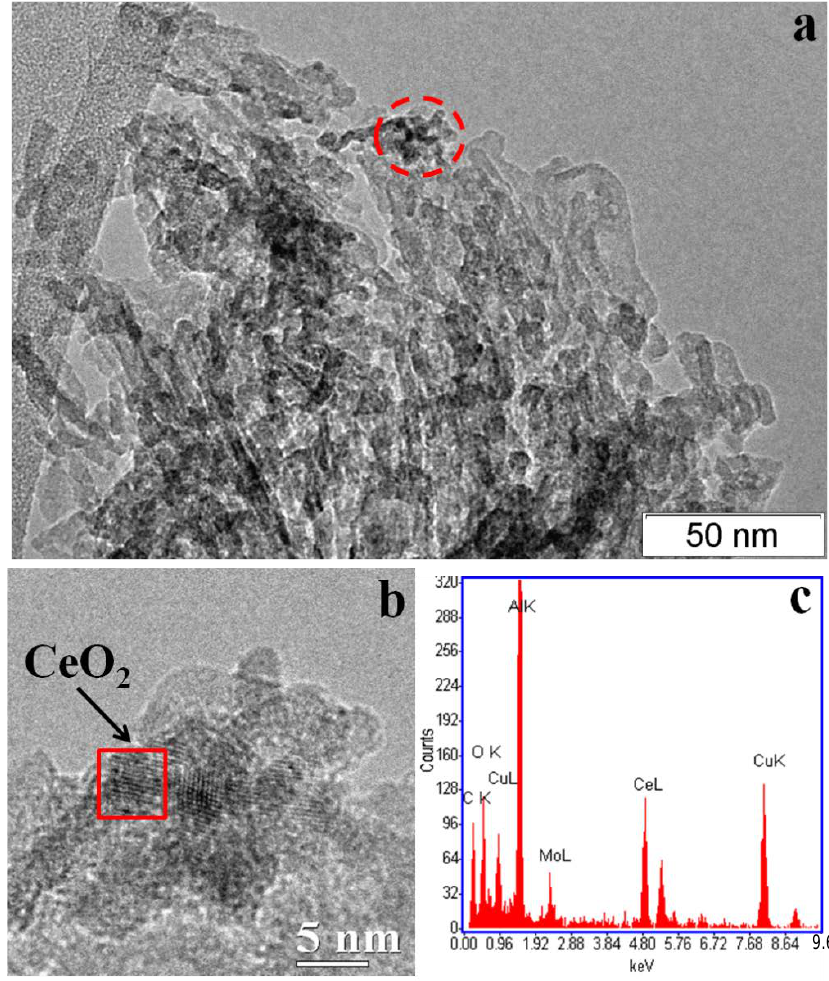
Figure 3. TEM image ( a ) of the used CuO-CeO 2 / γ -Al 2 O 3 catalyst and the HR TEM ( b ) and EDX spectra ( c ) of the marked